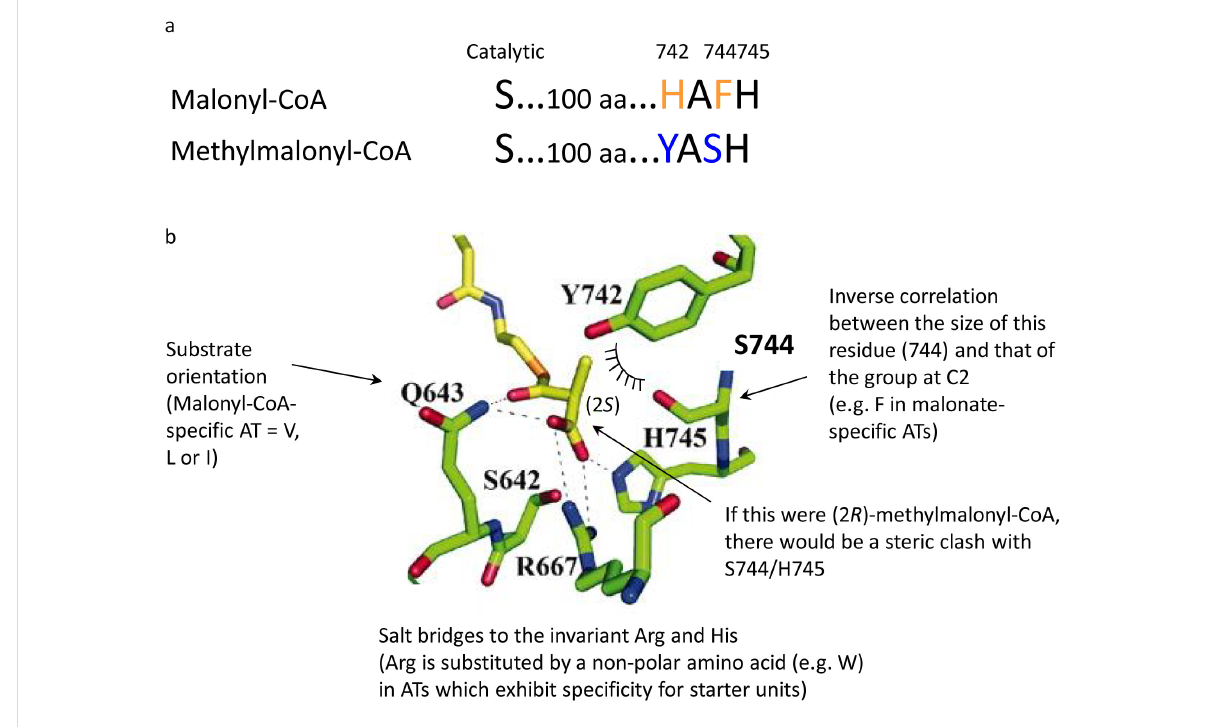
Figure 7: Model for substrate selection by AT domains. a) Sequence motifs in malonyl- and methylmalonyl-CoA-specific ATs which correlate with substrate choice. A HAFH motif is present some 100 amino acids downstream of the active site serine in malonyl-CoA-specific AT domains, while the corresponding sequence is YASH in methylmalonyl-CoA-specific ATs. The numbering is as in DEBS 3 (domain AT 5 ). b) Model for the molecular basis of specificity for (2 S )-methylmalonyl-CoA based on the crystal structure of DEBS AT 5 solved in the presence of acetate [38]. This shows notably the proposed role of the Y, S and H residues of the conserved recognition motif. Reprinted with permission from [38]. Copyright 2006, National Academy of